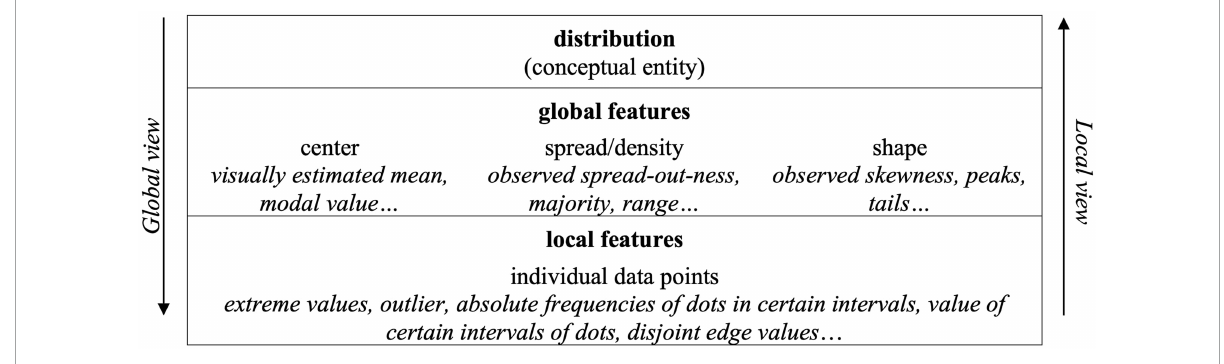
TABLE 1 Perspectives on data distributions: Local vs. global